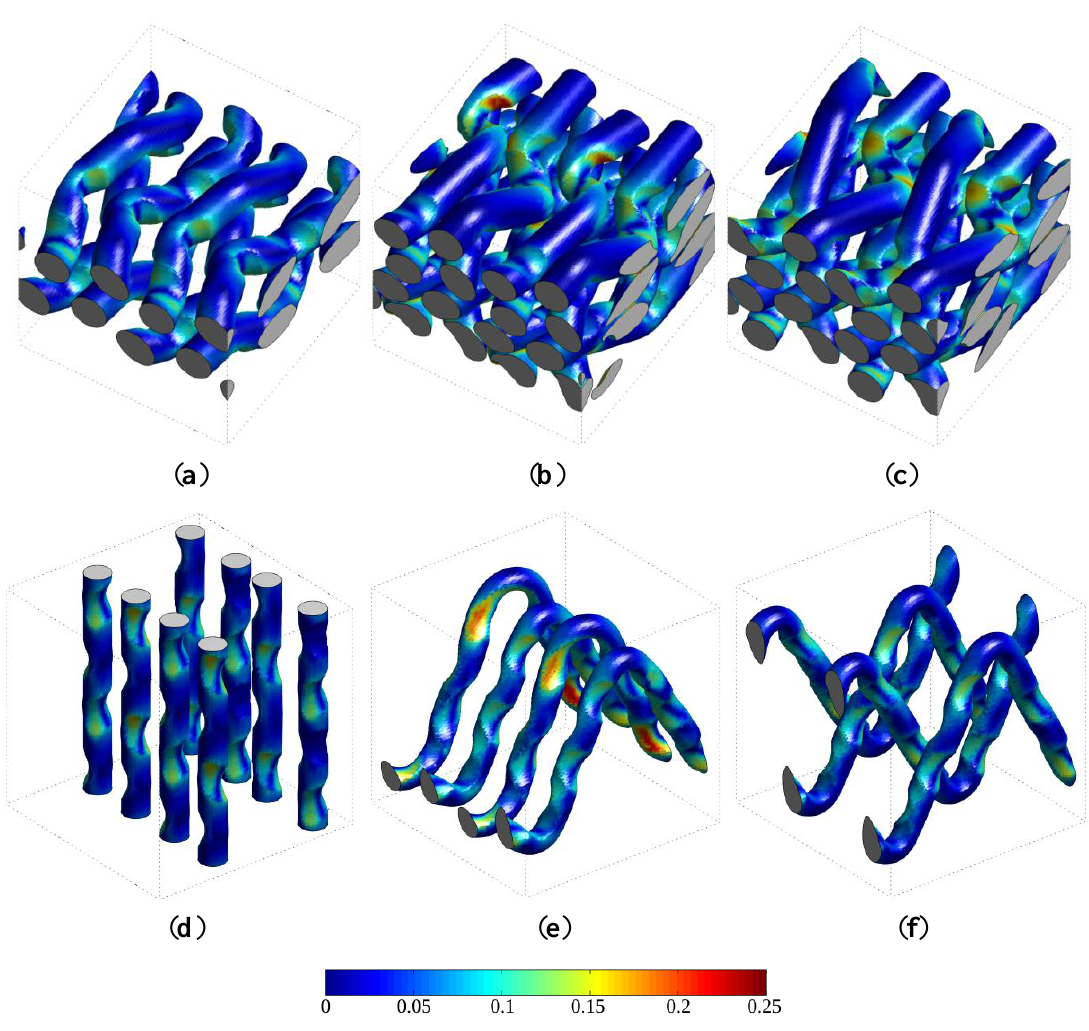
Figure 16. Interfacial tangential stress (relationship (8)) for a tensile strain of 1% in the warp average direction for the three considered RVEs. ( a – c ) Interface between warp yarns and matrix; and ( d – f ) Interface between binders (2.5D RVEs) or vertical wefts (3D RVEs) and matrix. The maximum stress value in the scale is 0.25